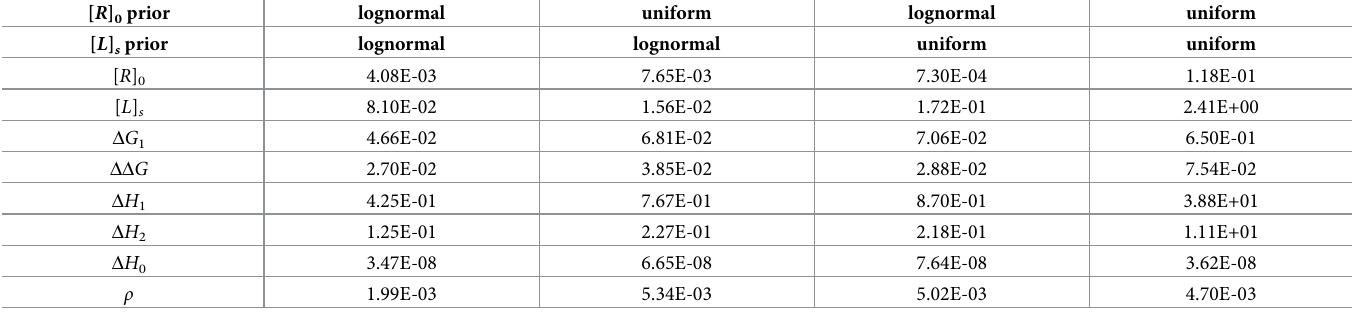
have complex structure. The simplest posteriors are from the 2C model. For the Fokkens_1a, Fokkens_1e, and Baum_60_2 datasets, in which the integrated heat is a sigmoidal function, the posteriors show simple unimodal peaks and essentially linear correlation between parameters. Table 2. Root mean square error of the mean. The root mean square error, or root mean square difference between the estimate and the true value, of the mean parameter value from the Bayesian posterior. [ R ] 0